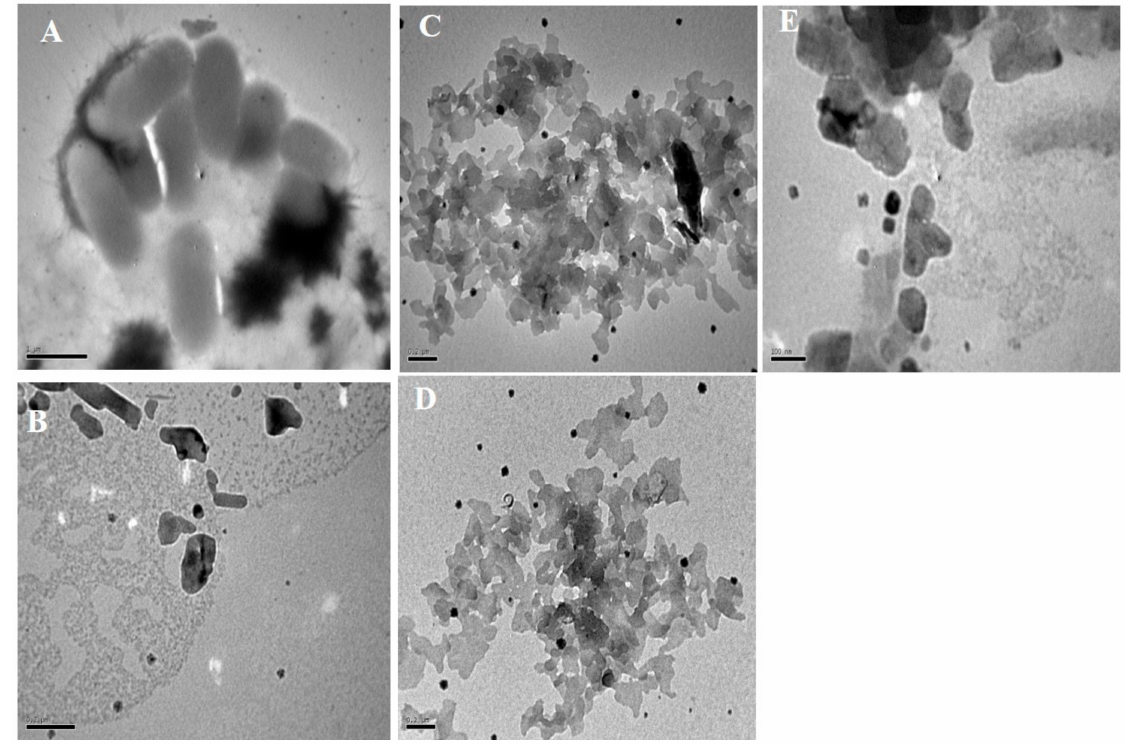
Figure 2. Effect of the tested compounds 3 , 12 , 13 and 16 on structural identity of E. coli. TEM Microgram of E. coli (Control,